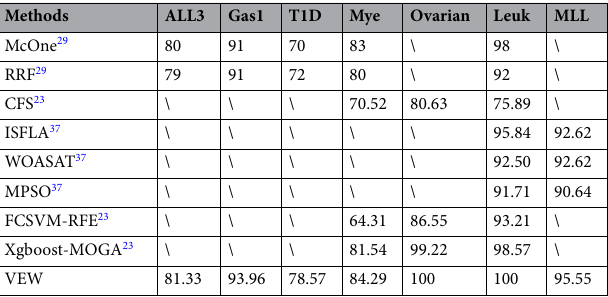
Table 4. Comparison between the VEW and other advance methods in